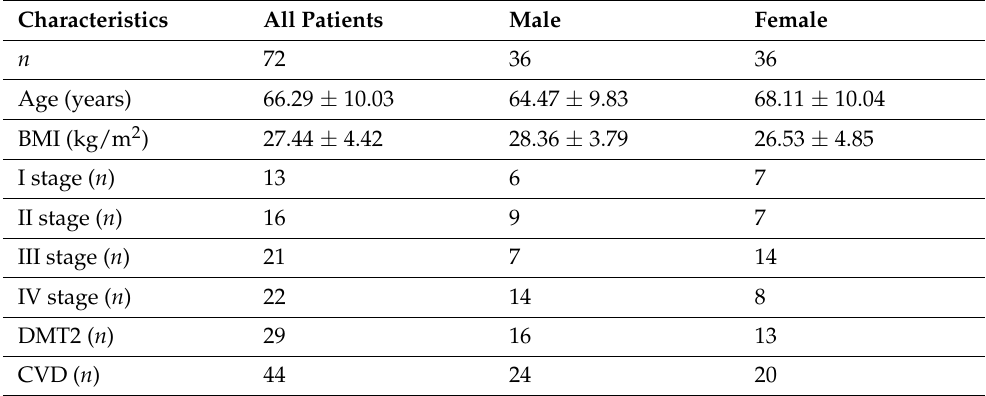
Table 1. The characteristics of the study